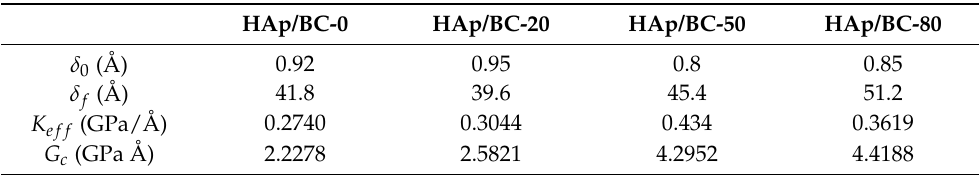
Table 2. Parameters of the system separation (i.e., 40% of the BC constraint), for the opening- mode test.